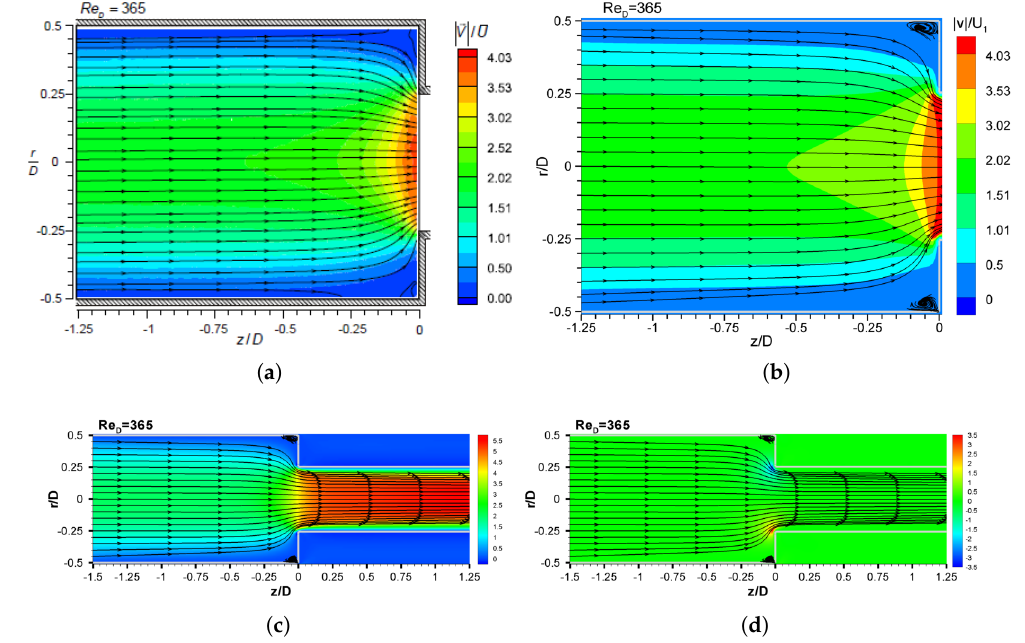
Figure 6. Streamline for Re D = 365 ( a ) upstream region for velocity magnitude [26], ( b ) upstream regions for velocity magnitude (present work), ( c ) both regions for axial velocity and ( d ) both regions for radial velocity.